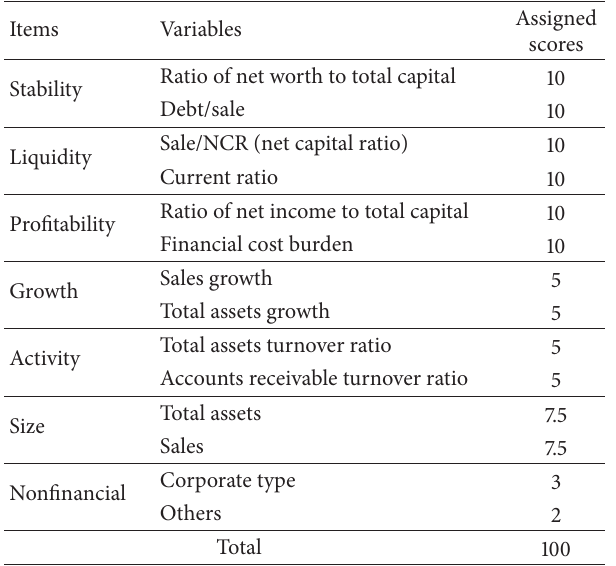
Table 3: Criteria for corporate governance.